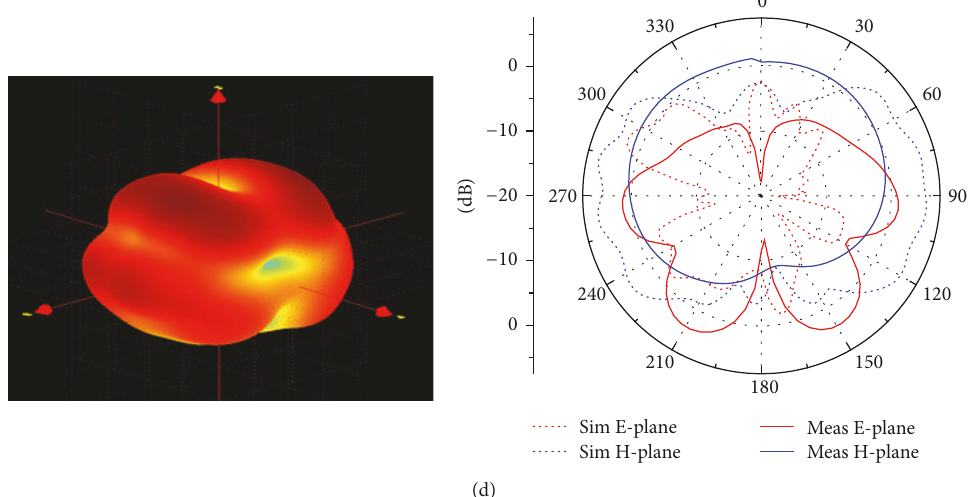
Figure 11: Measured and simulated 3D and E-plane/H-plane radiation patterns at (a) 1.6GHz, (b) 2.6 GHz, (c) 3.7 GHz, and (d) 5.3 GHz.